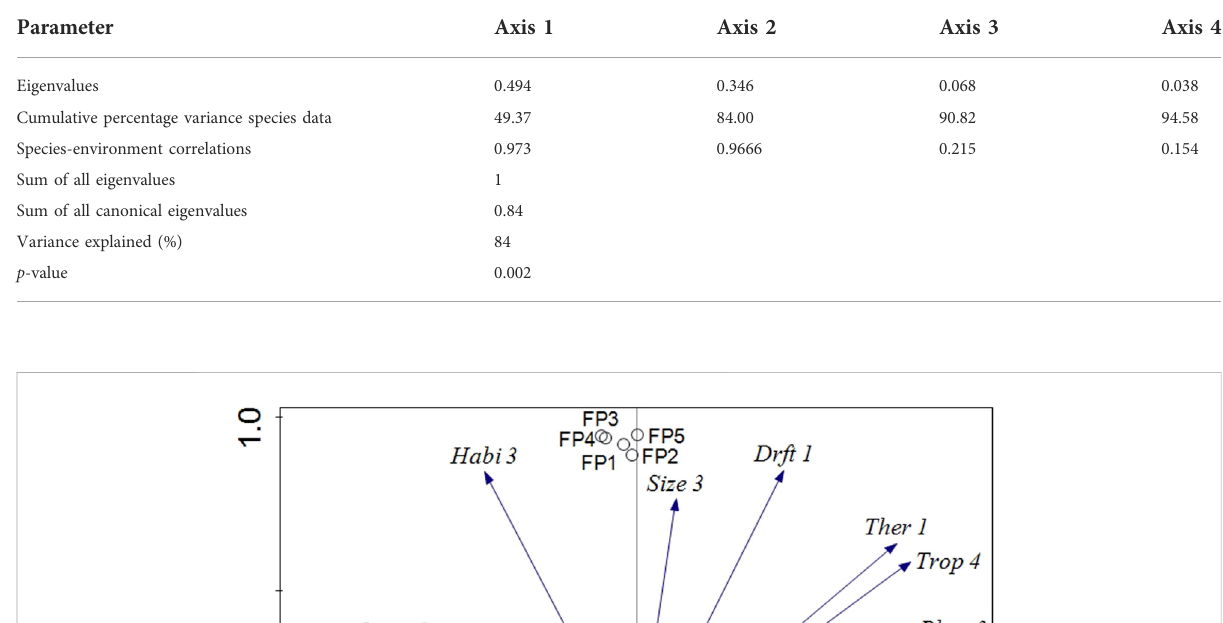
TABLE 1 Summary of the statistical characteristics of the four axes of the RDA analysis for the total data, FP data, MP data, and AM data.